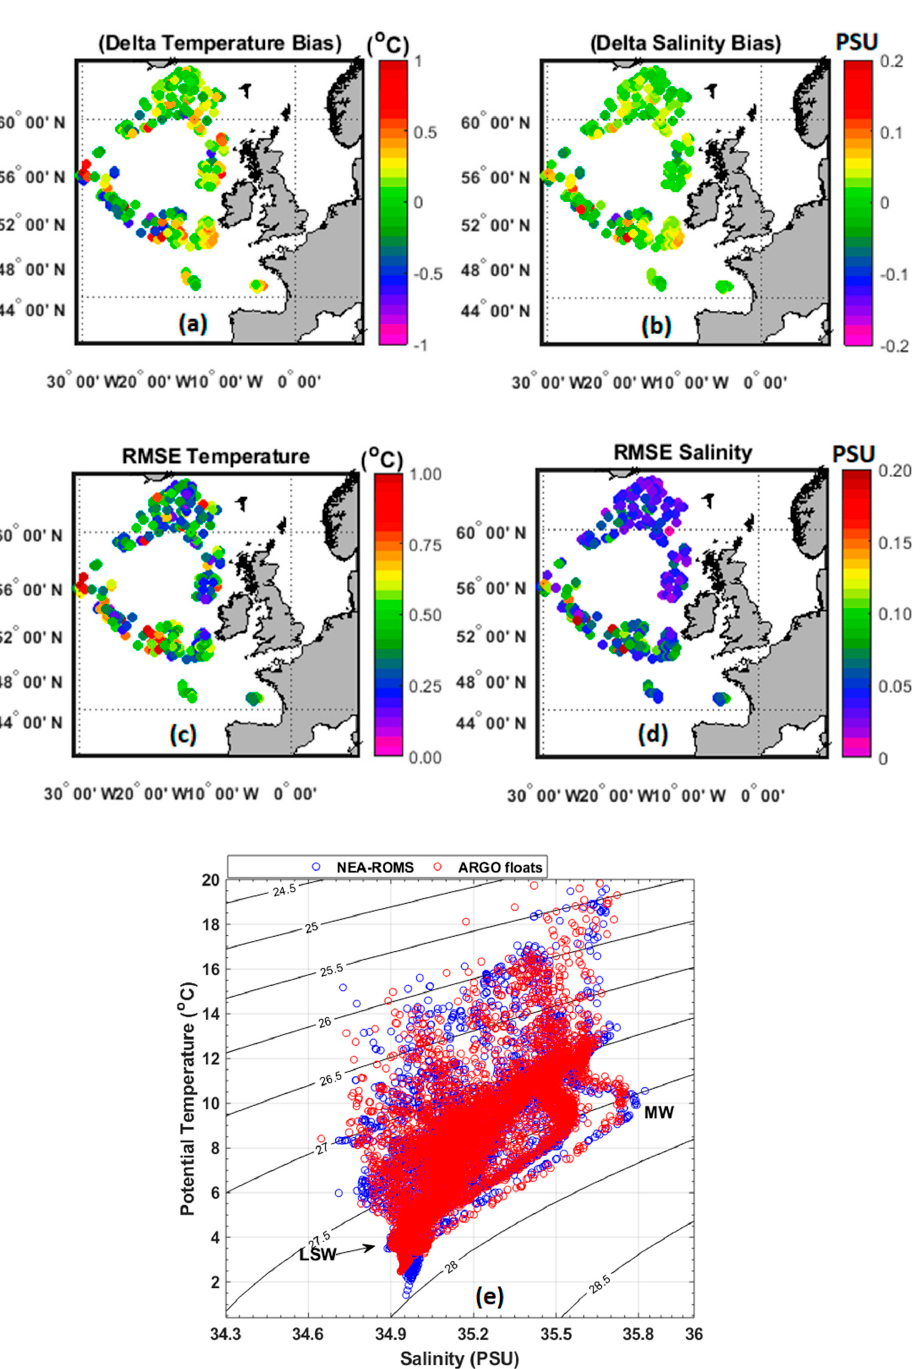
Figure 6. The bias and RMSE between NEA_ROMS and 304 ARGO float profiles locations in 2019. ( a ) Bias temperature, ( b ) bias salinity, ( c ) RMSE temperature, ( d ) RMSE salinity, ( e ) T-S diagram for NEA_ROMS and ARGO floats profiles.